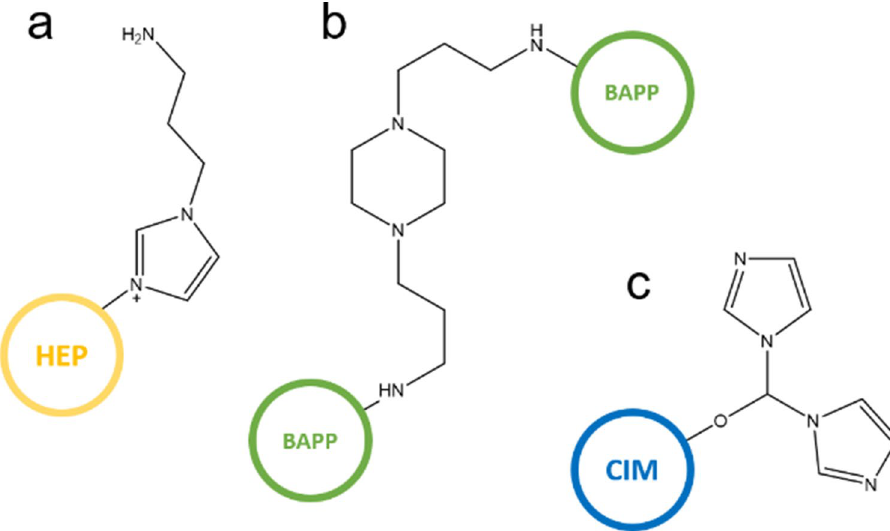
Figure 1. Simplified scheme of the structure of the amino functionalities in the ( a ) HEP, ( b ) BAPP and ( c ) CIM.